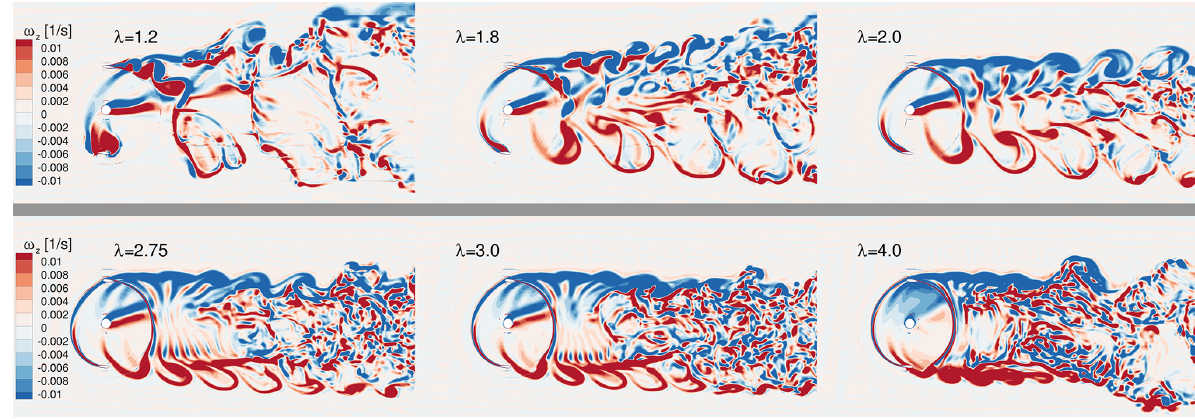
Fig. 14. The curves at all turbine positions show good agree- ment in the region of the inertial range of scales with the Kolmogorov f − 5 / 3 spectrum. It indicates that the turbulence is propagated effectively through the domain until it reaches the relevant positions of the wind